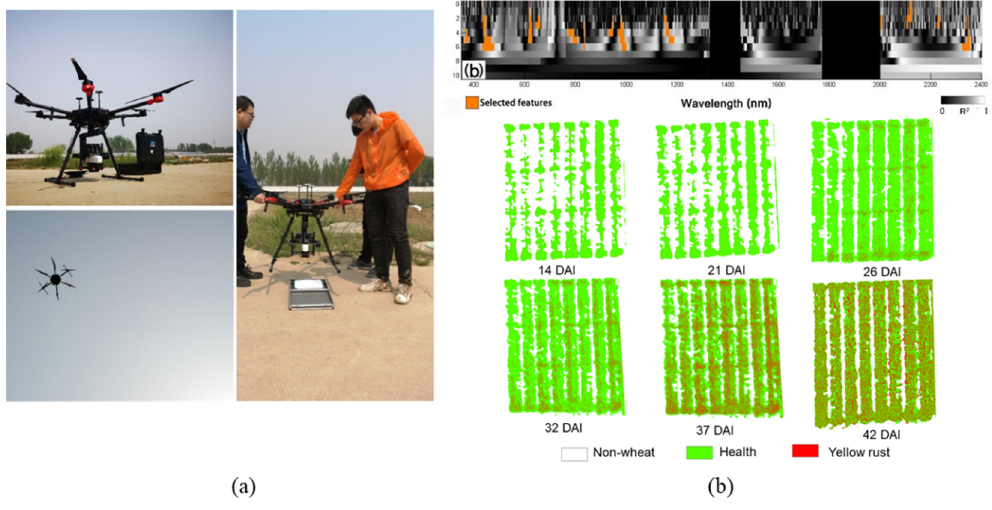
Figure 5. Acquisition of UAV hyperspectral images ( a ), and extraction of wavelet features and results of wheat yellow rust monitoring ( b ) .